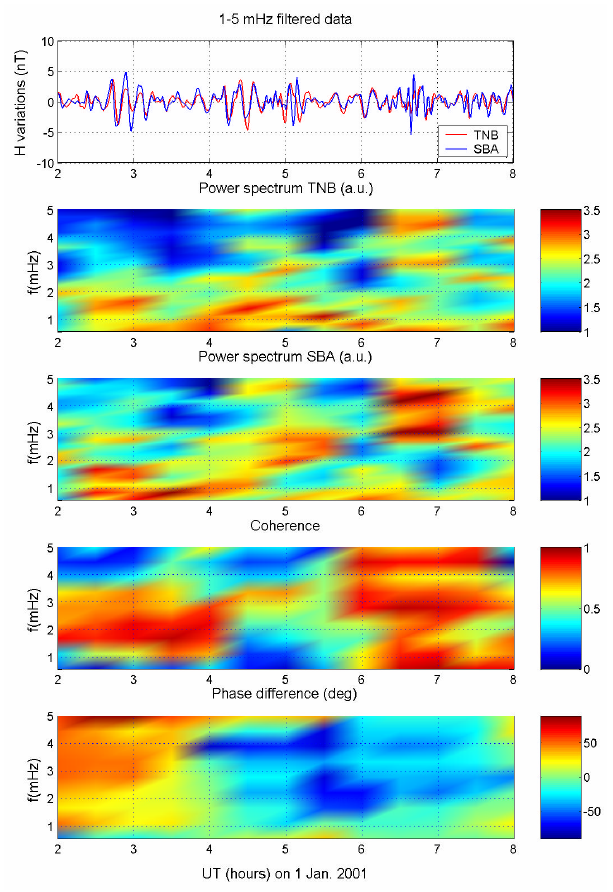
Fig. 6. Analysis of the event occurring between 15:00 and 23:00 UT on 2 February 2001. From top: variations of the geomagnetic field H component at the two stations, filtered in the 1–5mHz frequency range; power spectra at TNB and SBA; coherence and phase differ- ence between the two stations. MLT noon at SBA and TNB is at 19:00 and 20:00 UT, respectively.